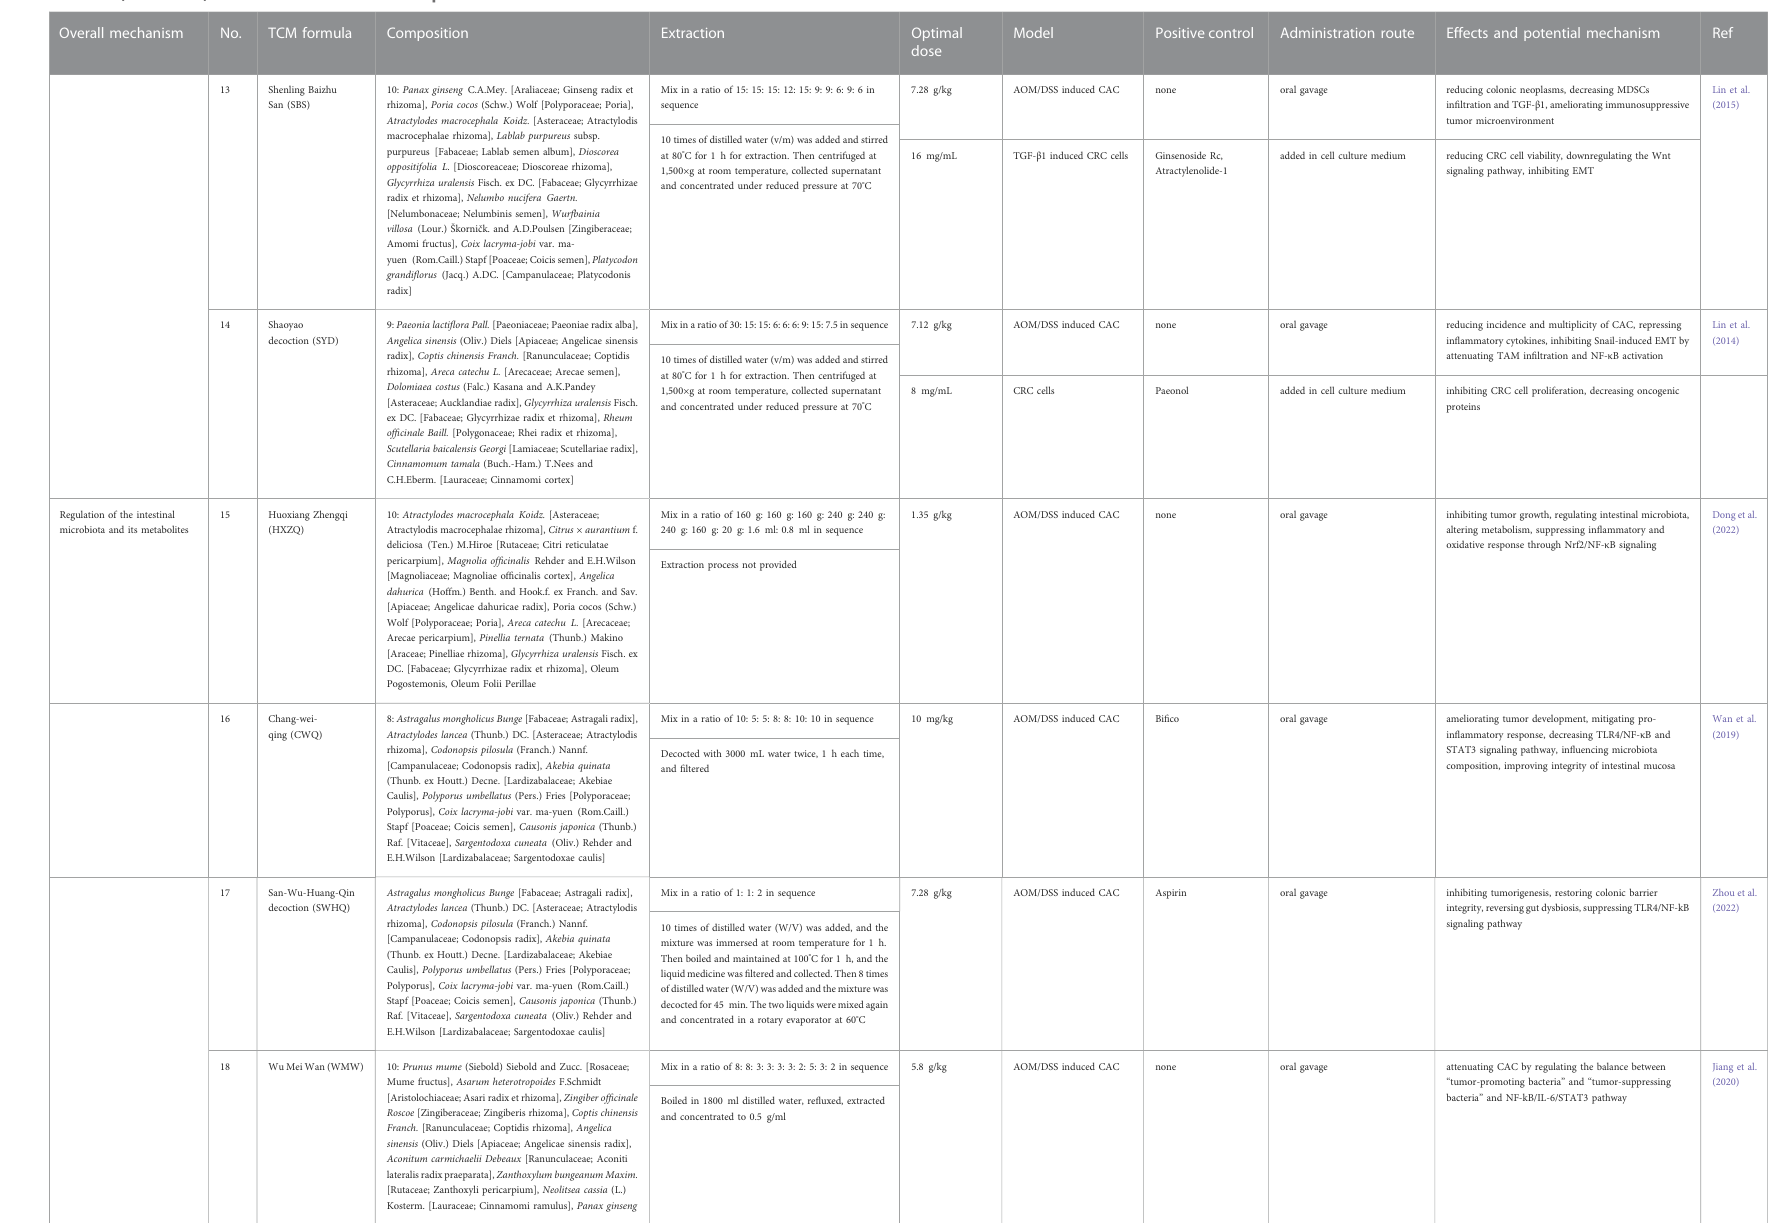
TABLE 1 ( Continued ) Lists of TCM formulas with potential anti-CAC